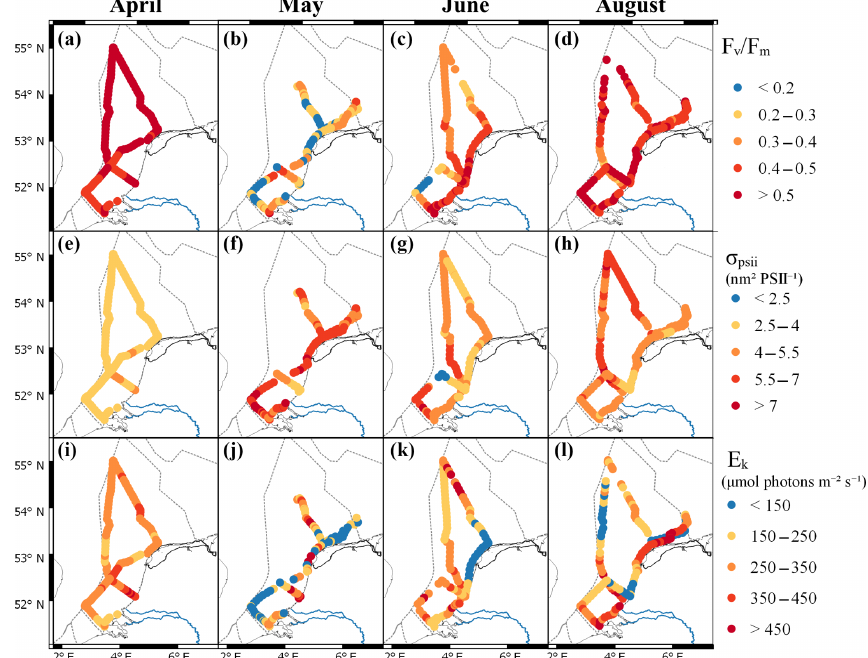
Figure 4. Maps of the photophysiological parameters F v /F m (a–d) , σ PSII ( e–h ; nm 2 PSII − 1 ) and E k ( i–l ; µmol photonsm − 2 s − 1 ) per month (from left to right: April, May, June, and August). For more details on the location see Fig. 1. Figure made with QGIS v2.14.2 using EEZ zone data from the Flanders Marine Institute (2018).